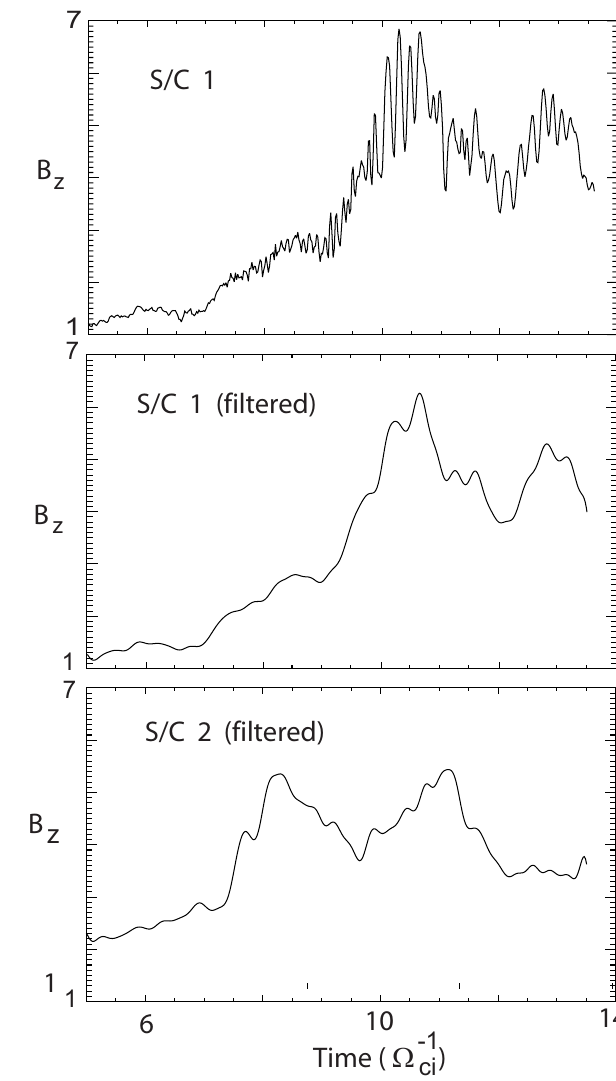
Fig. 12. From top to bottom: magnetic field B z profile recorded by an artificial spacectraft (S/C 1) moving in the simulation from upstream to downstream, same profile after high-pass filtering, high pass-filtered magnetic field profile recorded by second spacecraft (S/C 2) moving with the same velocity but displaced by ∼ 50 λ e relative to S/C 1.